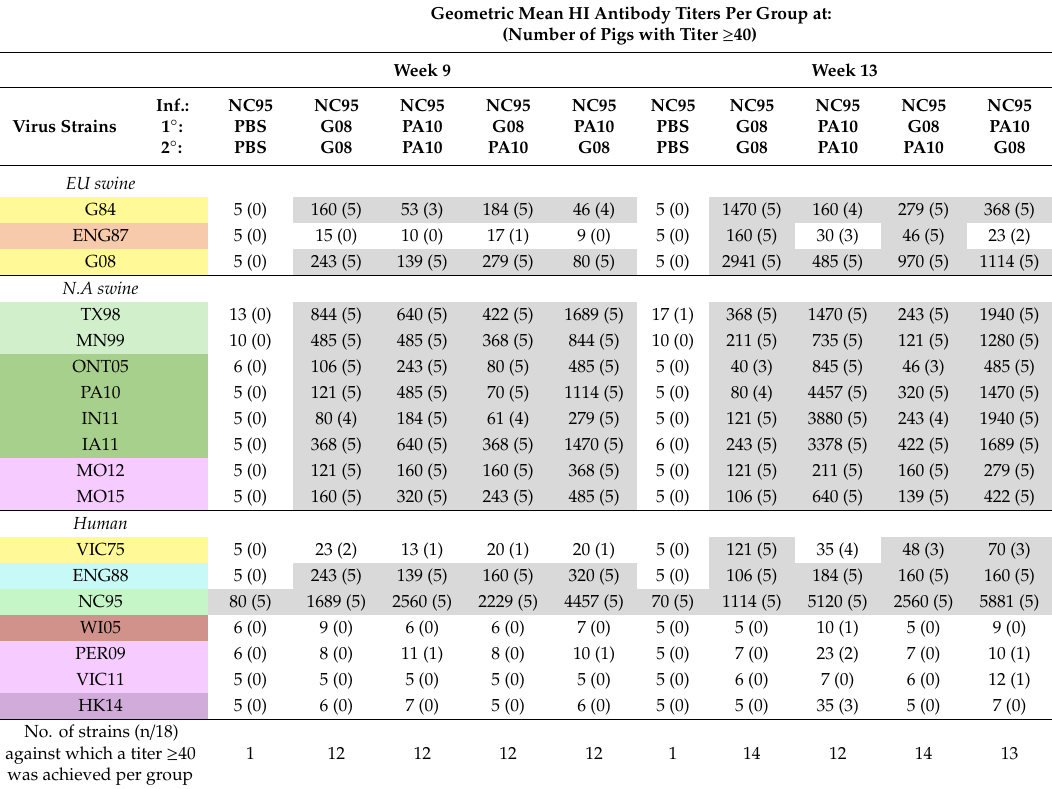
Table3. MeanHIantibodytitersagainstH3N2influenzastrainsusedforimmunizationandantigenically distinct strains in pigs of di ff erent vaccine